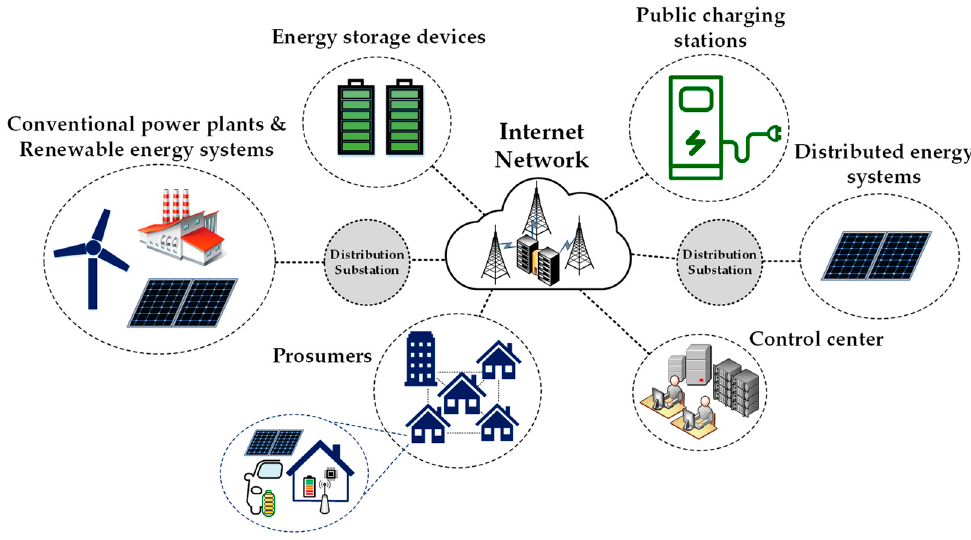
Figure 12. Architecture of the IoE framework [13,15,77].